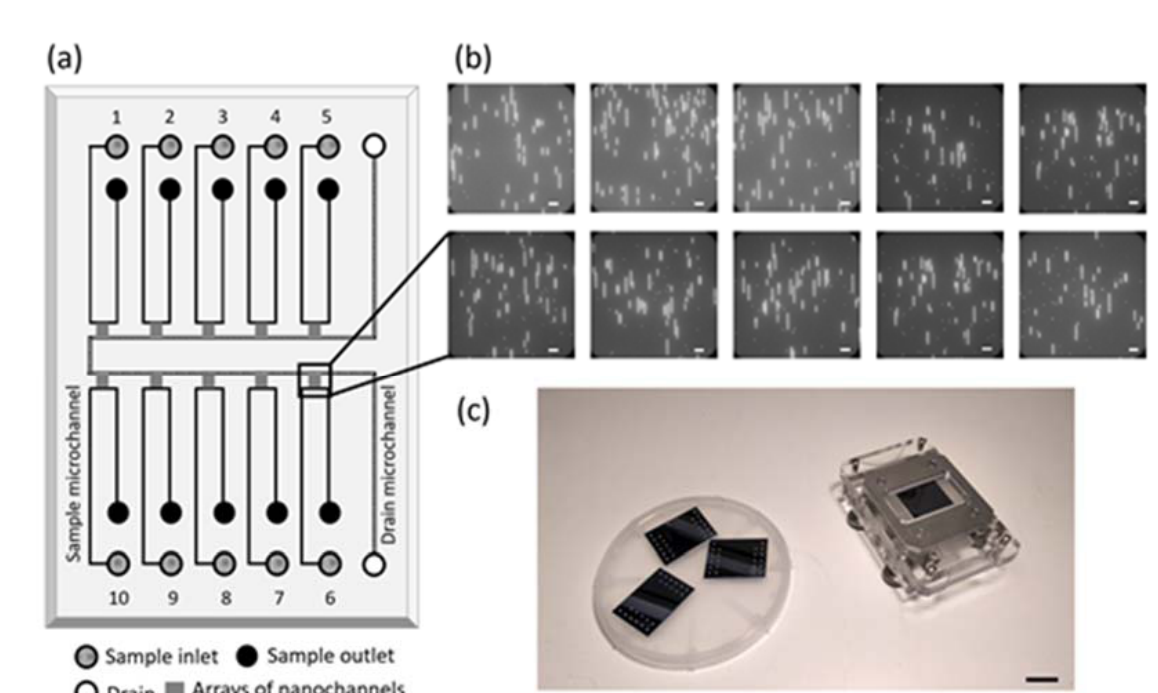
Figure 1. ( a ) Schematics of the multiplexed nanofluidic chip with inlet, outlet and drain. ( b ) Fluorescence images of single DNA molecules obtained simultaneously from the ten different nanochannel modules of the chip. Scale bar: 15 µ m. ( c ) Image showing the chips and the chip holder enabling automation of pressure-driven flow and ODM using an epi-fluorescence microscope. Scale bar: 20 mm.